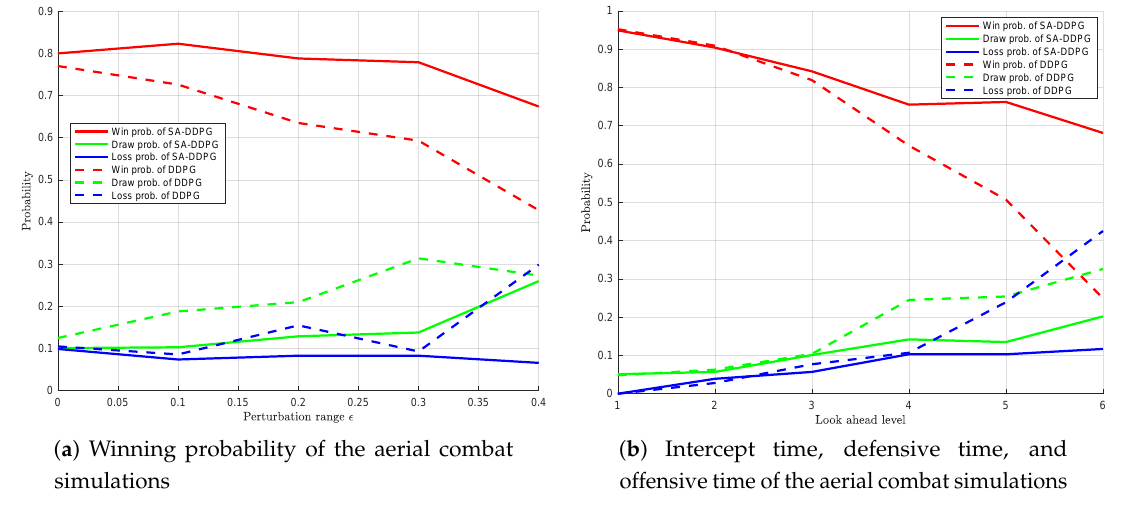
Figure 13. The results for robustness evaluation of the aerial combat maneuver